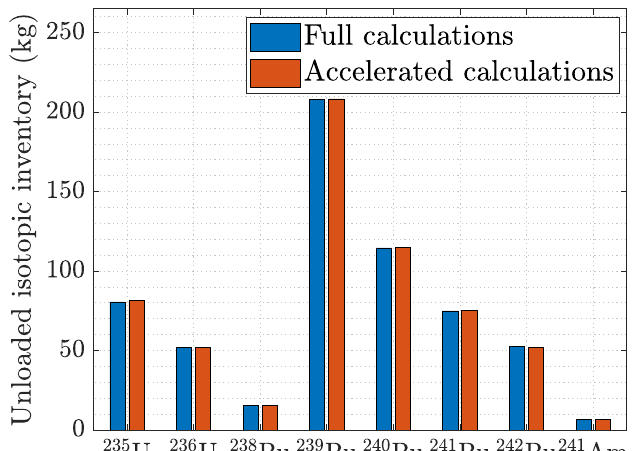
Fig. 8. Unloaded actinides inventories obtained with full and accelerated